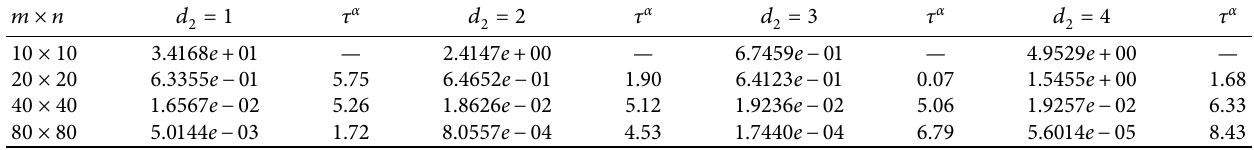
� 7 for Example 2. 1